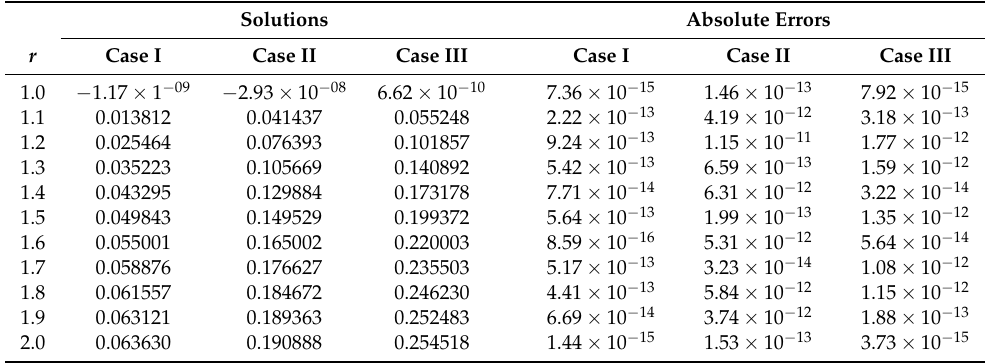
Figure 8. Behaviour of fitness value during the 100 executions of the proposed LNN-GNDO-SQP algorithm for various scenarios of the flow of Johnson Segalman fluid on the surface of an infinitely long vertical cylinder. ( a ) SCENARIO I. ( b ) SCENARIO II. ( c ) SCENARIO III. ( d ) SCENARIO IV. Table 3. Approximate solutions and Absolute errors obtained by the LNN-GNDO-SQP algorithm for SCENARIO I of the drainage problem.